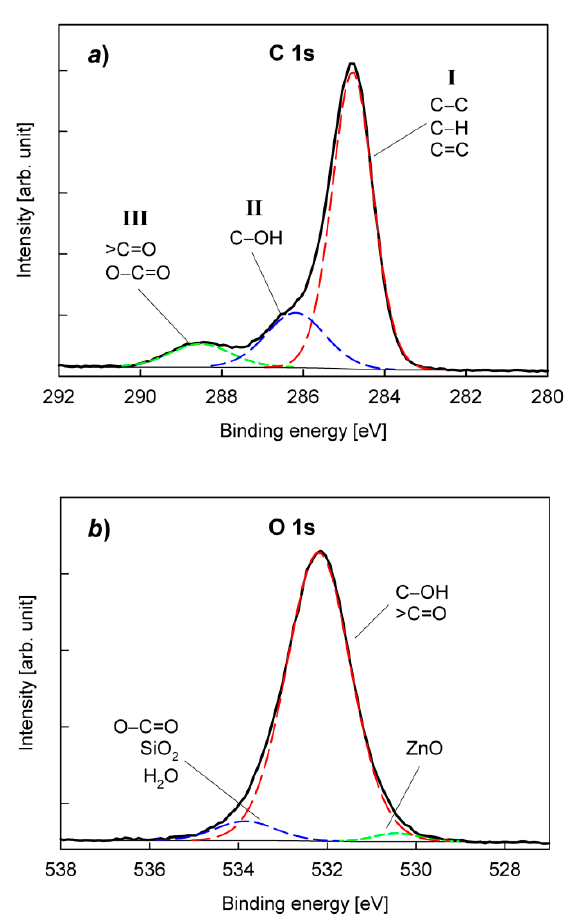
Figure 6. XPS narrow spectra for SBS rubber with 50 phr of carbon black, after plasma treatment (O 2 plasma, 50 W): ( a ) C1s; ( b ) O1s.